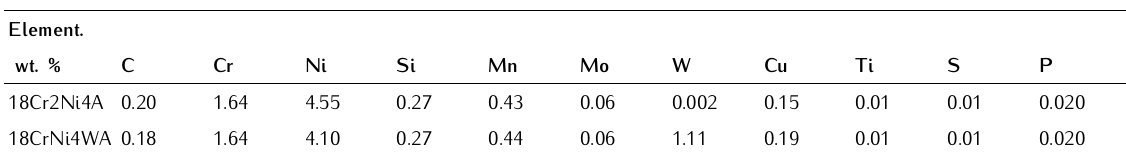
Table 1. Chemical composition of the used materials (wt.%). Element.